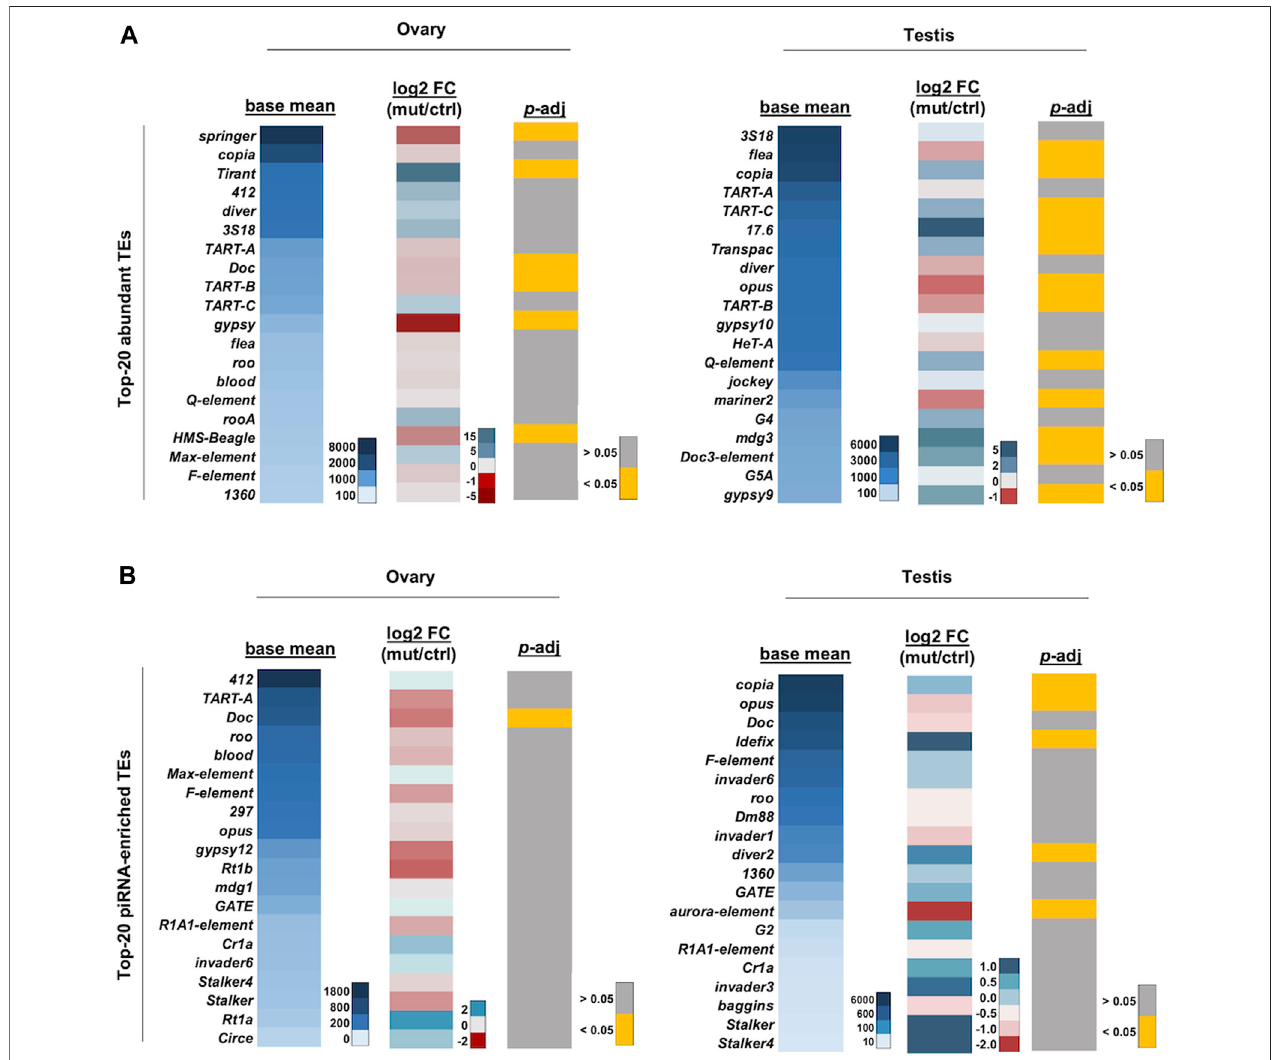
FIGURE 5 | TE expression pro fi le in kots mutant gonads. (A) Heatmaps showing the averaged read counts between the control and mutant (left panel), log 2 fold change(mutant/control;middlepanel),and p -adjustedvalues(rightpanel)ofthetop20mostabundantTEmRNAsinovariesandtestes,respectively. (B) Heatmapsasin (A) showing corresponding values for the top-20 piRNA-enriched